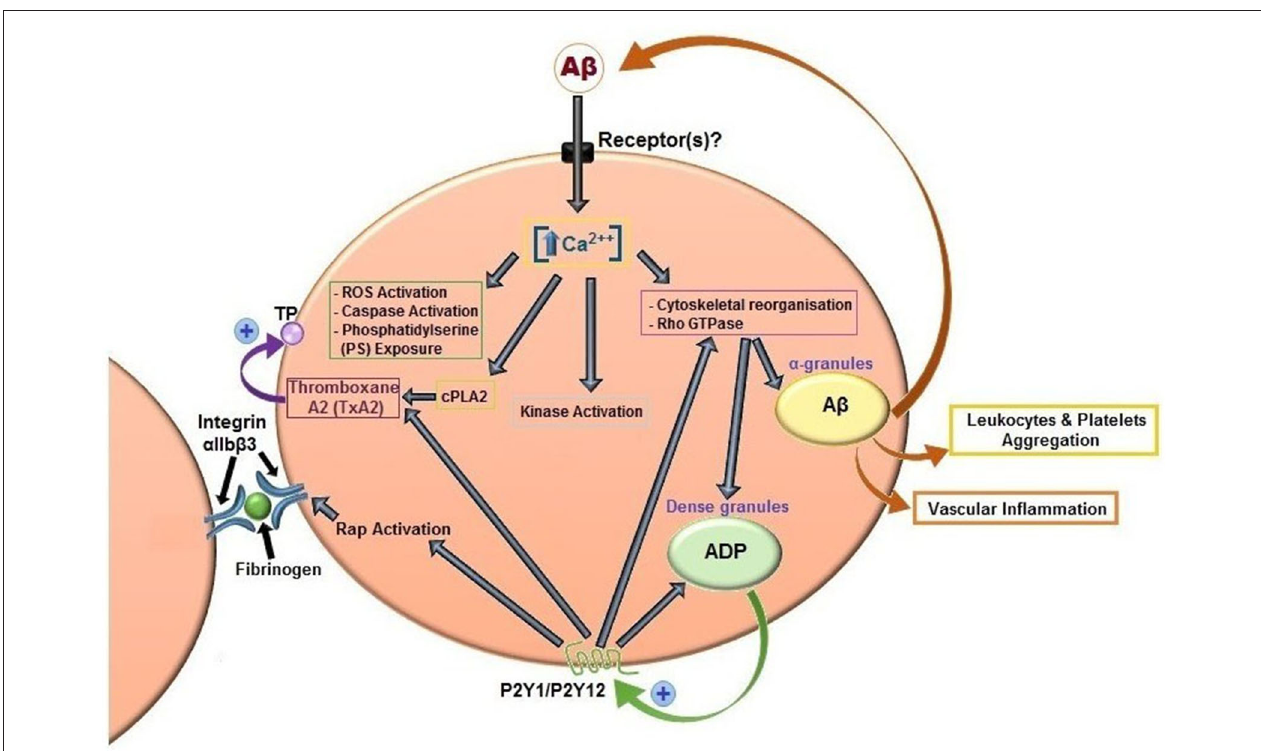
released by dense granules, and formation of TxA 2 reinforce platelet activation. A β peptides also promotes ROS formation, caspase activation and membrane scrambling. Activated platelets recruit leukocytes and promotes vascular